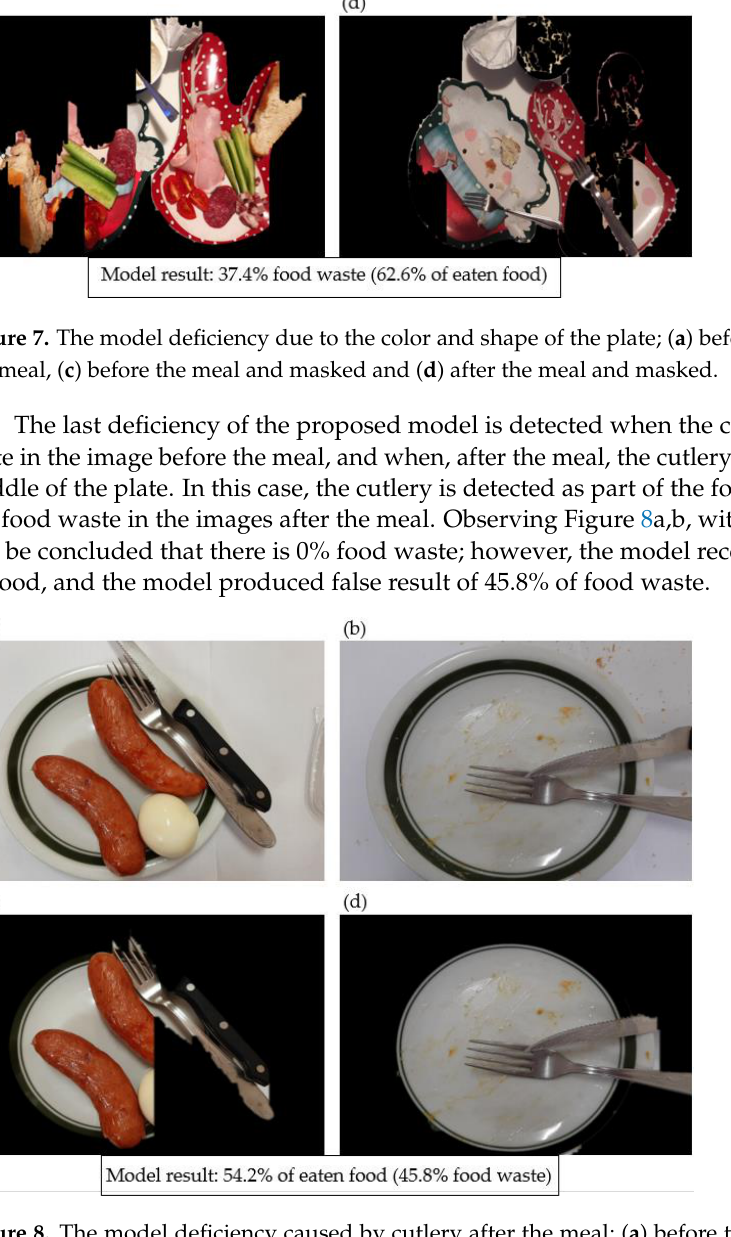
Figure 8. The model deficiency caused by cutlery after the meal; ( a ) before the meal, ( b ) after the meal, ( c ) before the meal and masked and ( d ) after the meal and masked. The food waste calculations were performed based on students’ plate images from the Republic of Serbia, and the results are presented in Table 3, where the average food waste is presented. Considering the previously explained model issues, it can be assumed that the food waste results presented in Table 3 are less accurate than those calculated using the model, as all the previously explained irregularities were also included in the students’ images. The variety of food waste percentage from different students might be due to the previously explained model deficiencies or inaccurate images. Table 3. Average student ’s food waste in Serbia. Food Waste, %